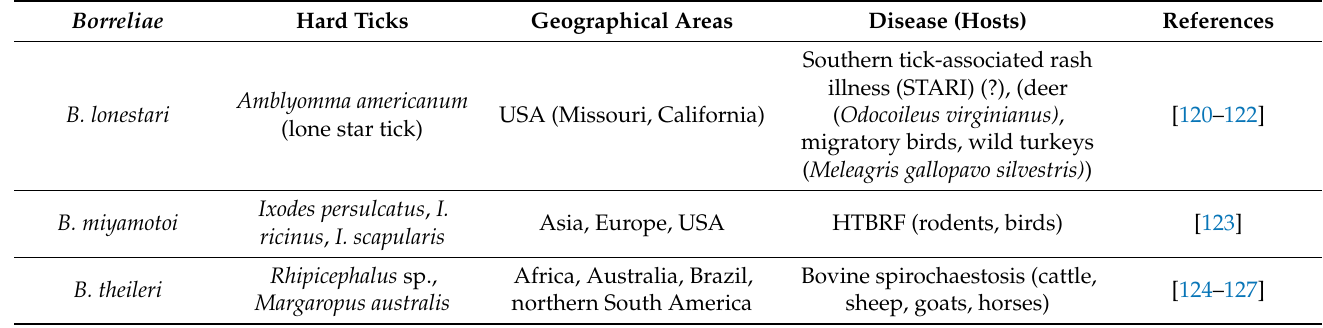
Table 4. Hard-tick-borne relapsing fever Borreliae